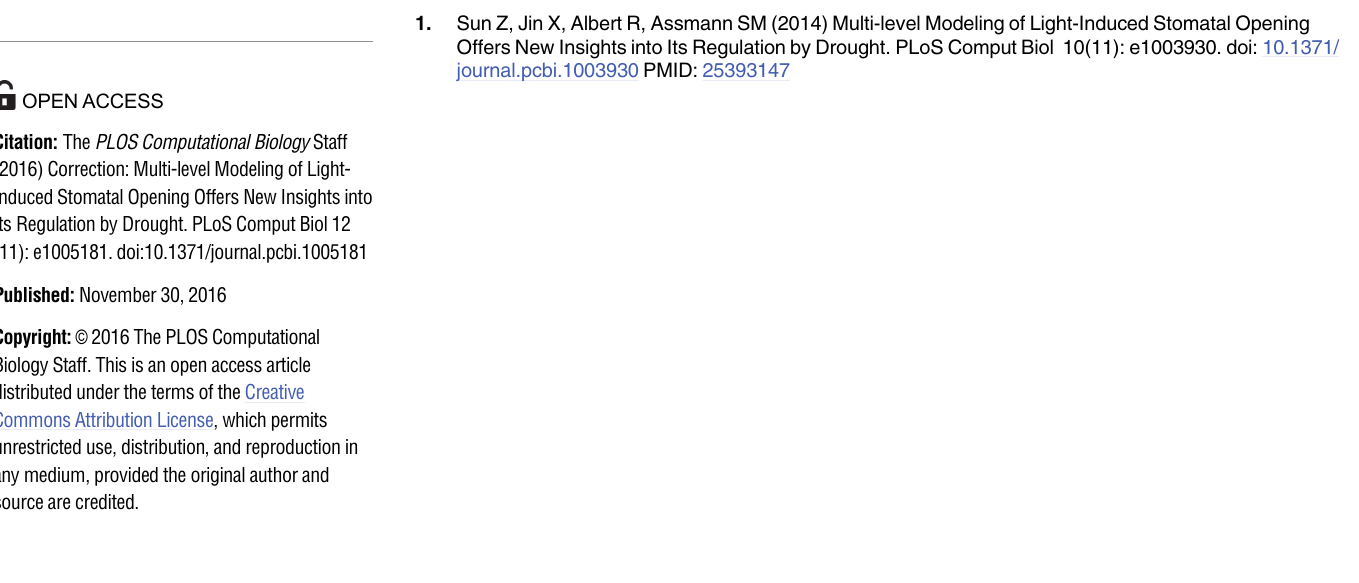
S4 Table. Compilation of comparisons between published experimental observations and the model’s results for simulations of the identical